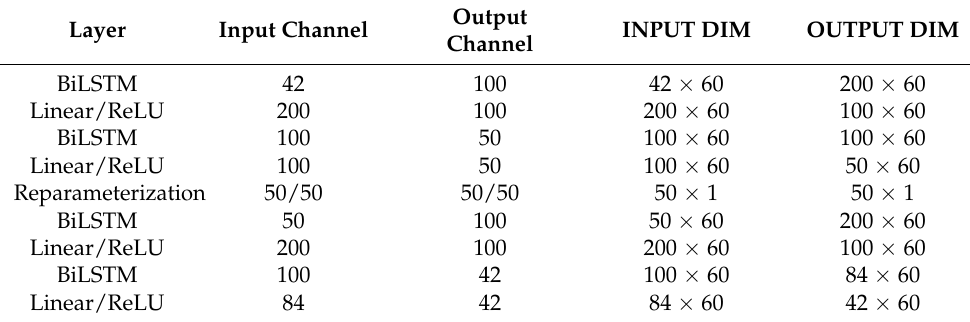
Table 3. The structure of the DLAN model for TEP.